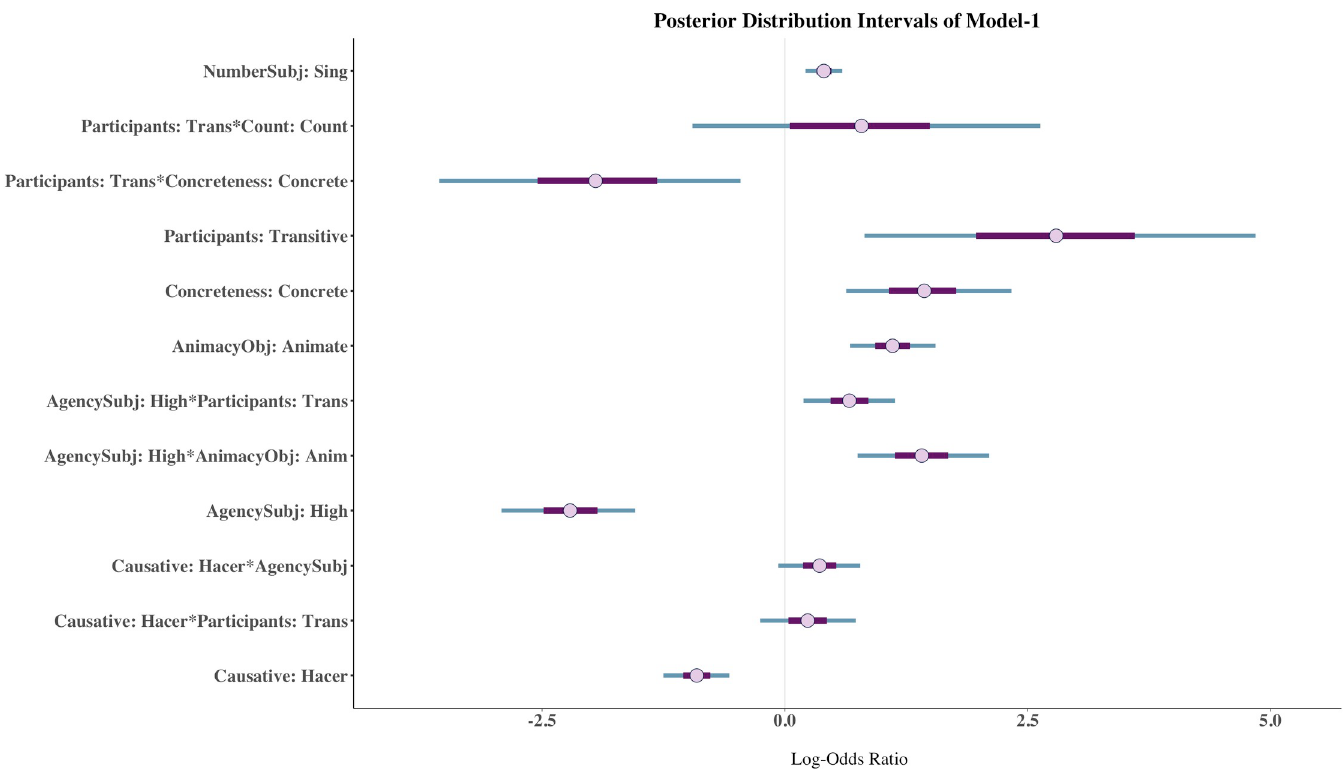
Fig 1. Posterior distribution intervals of terms with a Bayes factor larger than 1 in Model-1. The thicker purple lines show 50% and the thinner teal lines 90% credible intervals. The dot represents the posterior mean estimate.